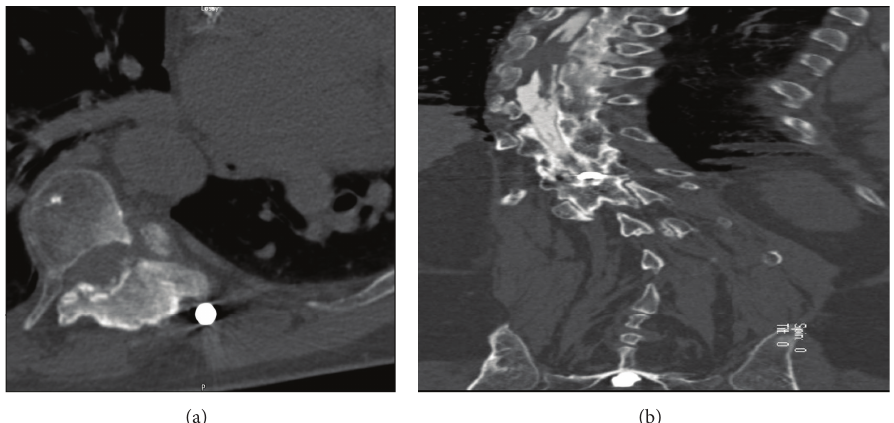
Figure 1: Axial and coronal reformatted CT myelogram images of thoracic spine illustrate compression of spinal cord to the left with complete contrast block at